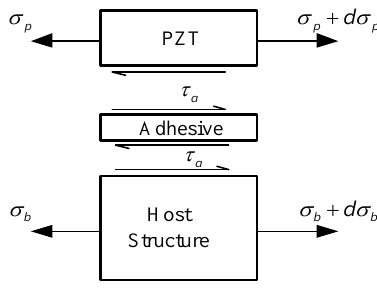
Figure 2. The force equilibrium of the micro structural element.